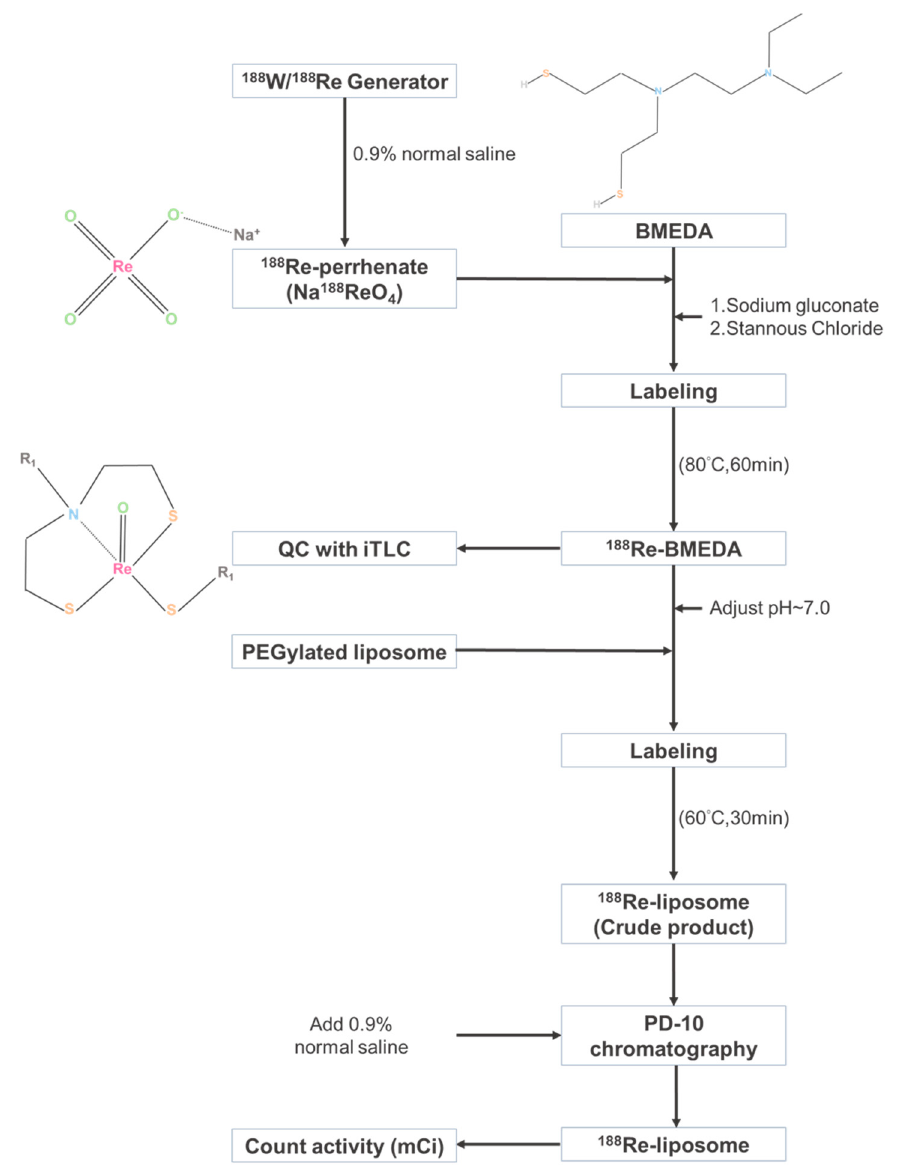
Figure 1. The flowchart of 188 Re-liposomal preparation. The chemical structures of Na 188 ReO 4 , BMEDA and formed 188 Re-BMEDA were also illustrated.